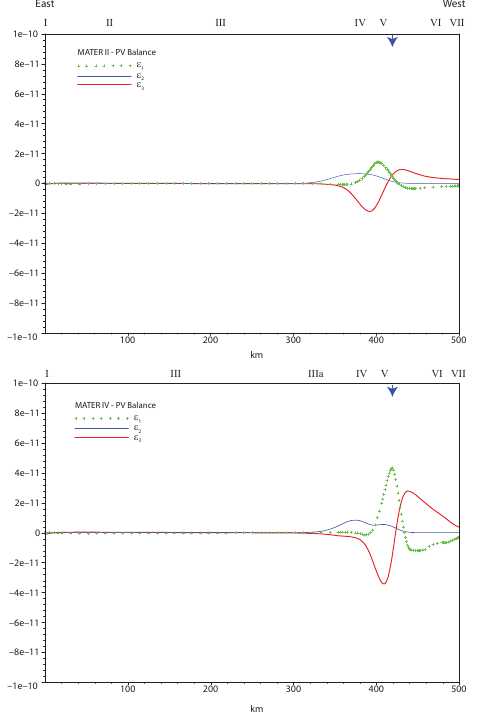
Figure 7. Analytic profile for the various terms in Eq. (18) along ξ (m), namely, the friction term (bold line), the PV-advection term (dots line), and the entrainment term (thin line). Position of the tran- sects is shown in Figs. 3 and 4, for the MATER II and MATER IV cruises, respectively. The black arrow shows the position of the sill.